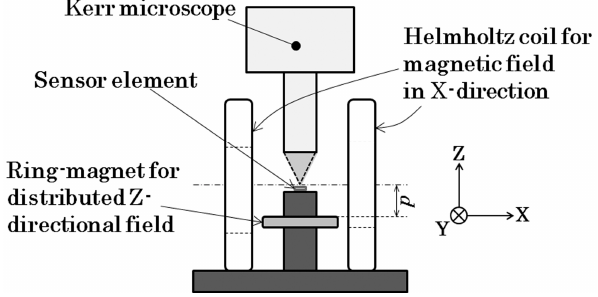
Figure 4. Schematic of the measurement apparatus.